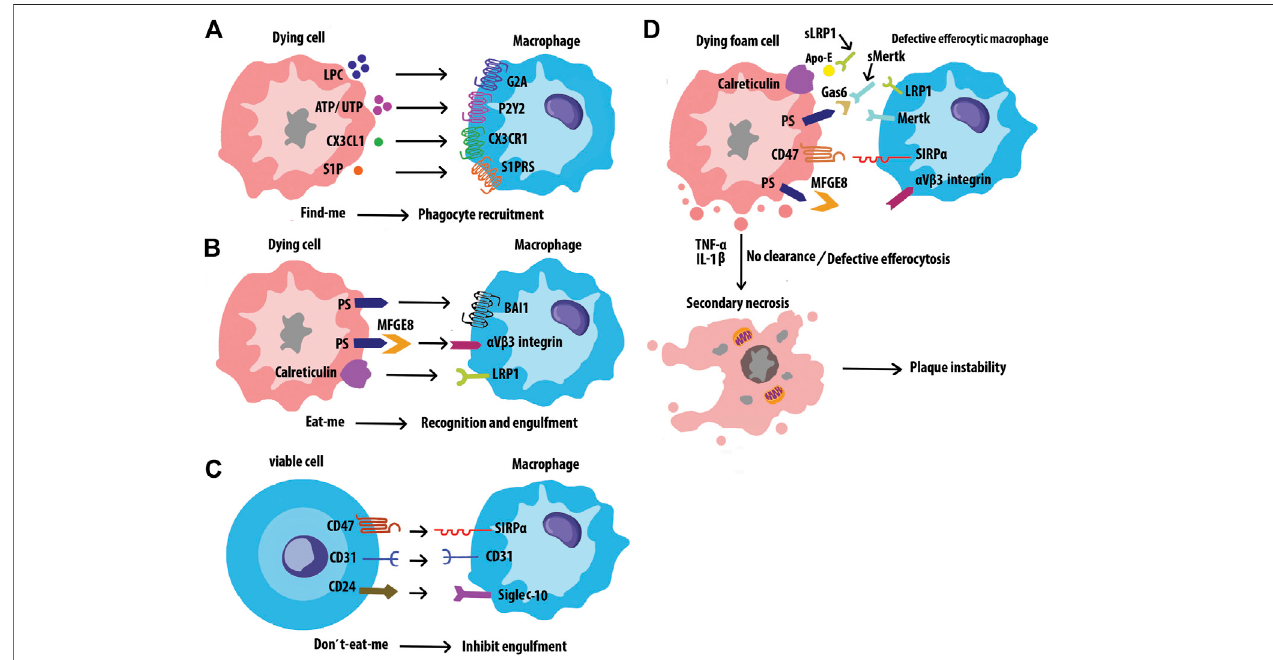
FIGURE 8 | Interactions of efferocytosis signaling. Find-me signals recruit phagocytes to the sites of cell death. The dying cells will express Eat-me signals to facilitate interactions with phagocytes. Non-ACs send a Don ’ t-eat-me signal to avoid efferocytosis when exposed to phagocytes. Defective efferocytosis leading to inef fi cient clearance of ACs and subsequent necrosis and in fl ammation in plaques.